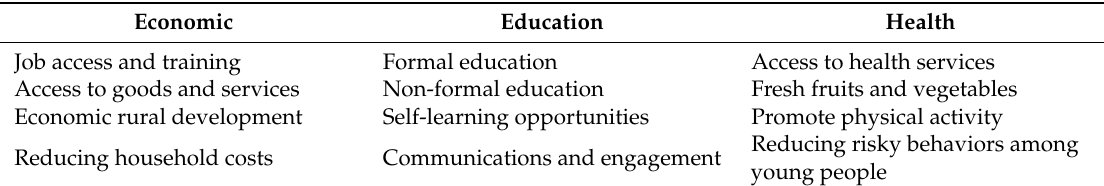
Table 4. Themes for impacts of public transportation identified by key